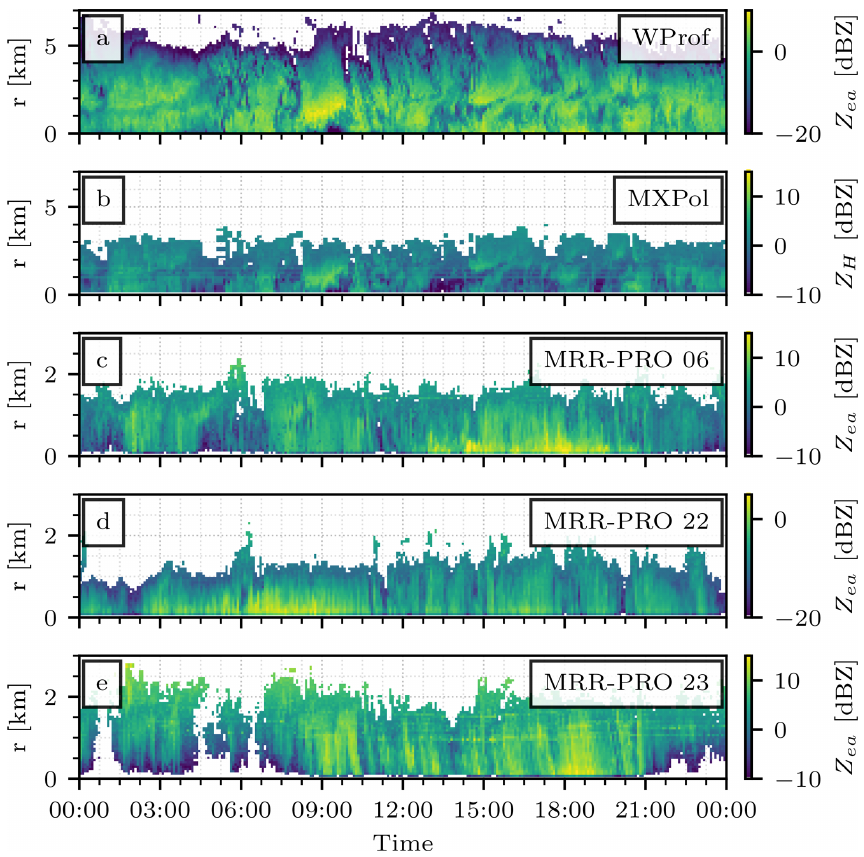
Figure 5. Measurements collected by the meteorological radars during the precipitation event on the 23 December 2019. The attenuated equivalent reflectivity factor collected by WProf and the three MRR-PROs is shown in panels (a) , (c) , (d) , and (e) . Panel (b) shows the horizontal reflectivity factor recorded by MXPol during the vertical PPI scans. Conditions on SNR analogous to the ones in Fig. 4 have been enforced on all radars. An additional condition on the co-polar correlation coefficient ( ρ hv > 0 . 6) has been imposed on the MXPol measurements. Due to the limited sensitivity of the MRR-PRO, the vertical extent of the bottom three panels has been limited to the first 3km of the